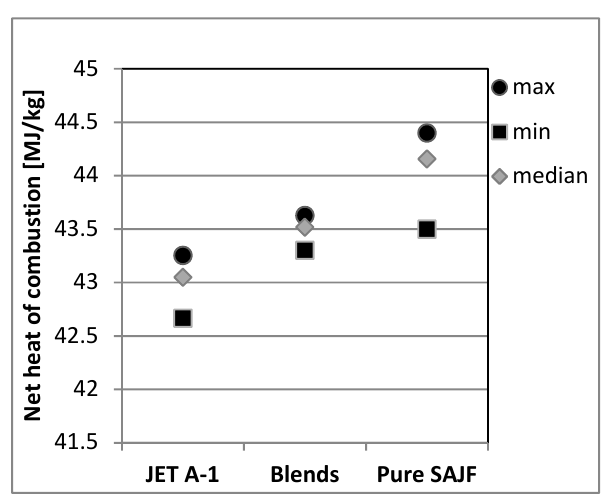
Figure 14. Net heat of combustion of crude-oil based Jet A-1 in comparison with alternative jet fuel blends.